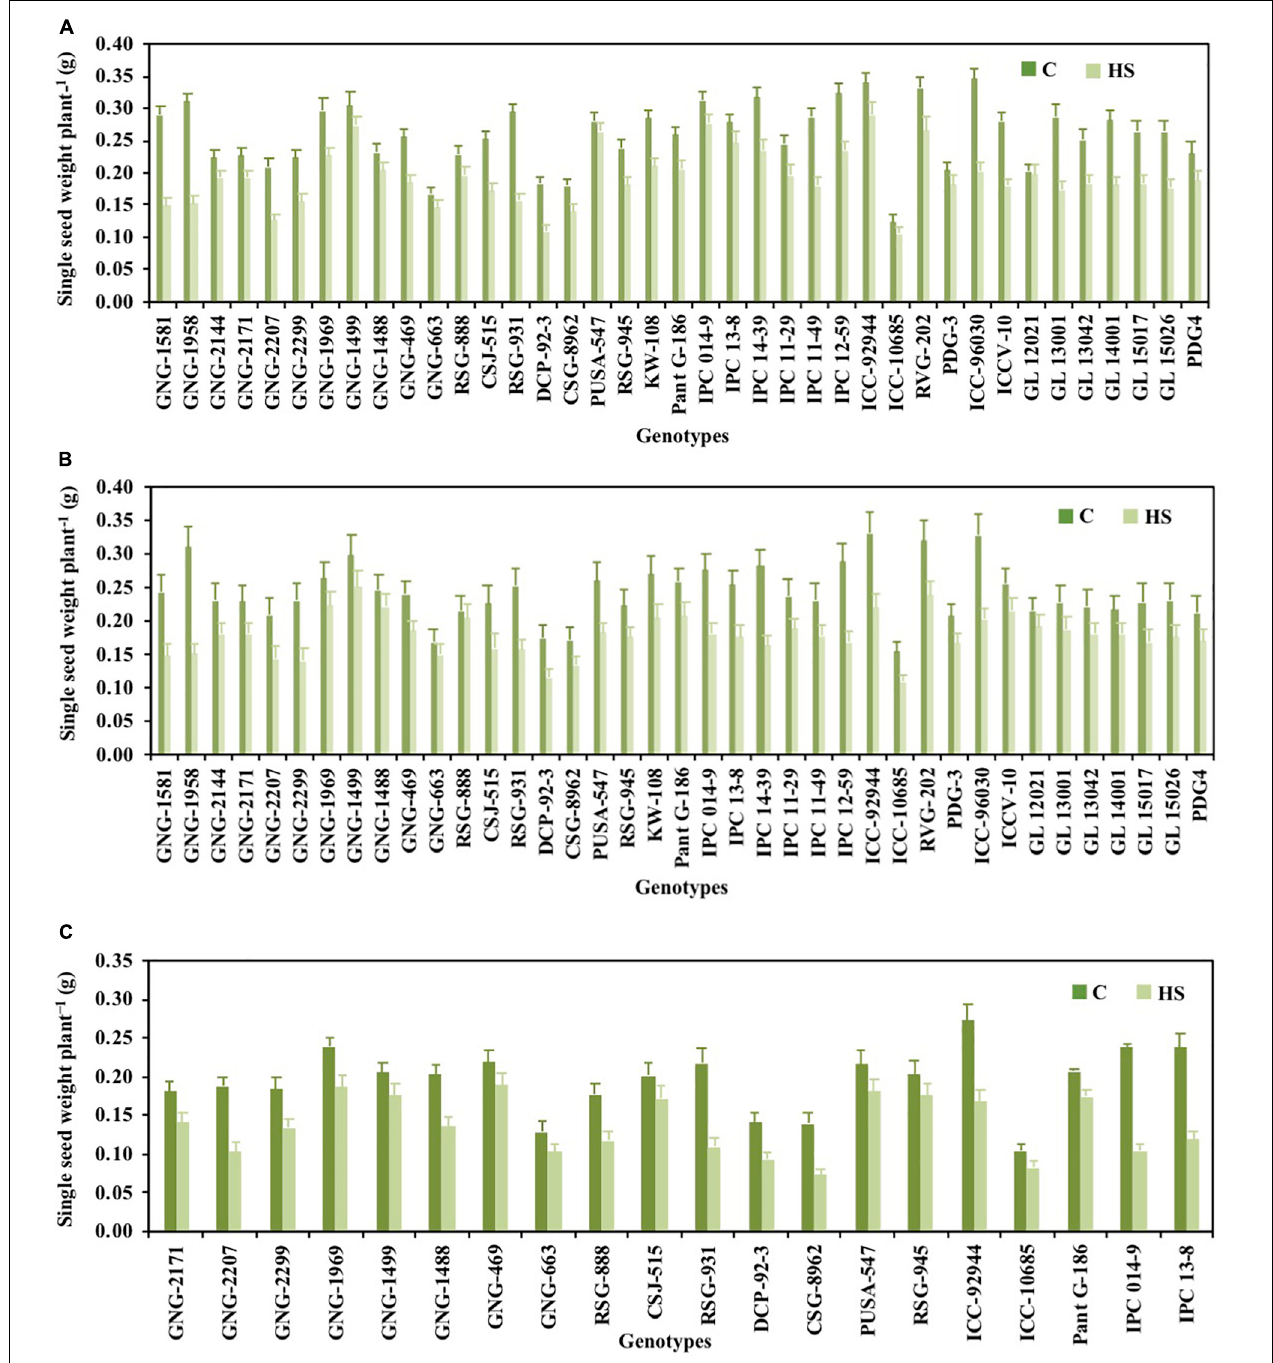
FIGURE 3 | Single seed weight of chickpea genotypes under control (normal-sown; C) and heat stress (late-sown; HS) environment during 2017–2018 (A) , 2018–2019 (B) and in control environment of growth chamber (GC; C-control; HS-heat stress; C) . LSD values ( P < 0.05); genotype × treatment: 0.15 (2017–2018), 0.17 (2018–2019), 0.14 (GC). Values are means + SE. ( n = 3).